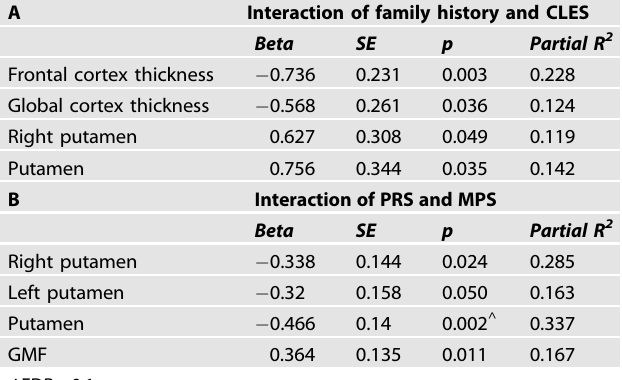
Table 3. Brain structure features with signi fi cant gene – environment interactions from (A) family history and CLES and (B) PRS and MPS,